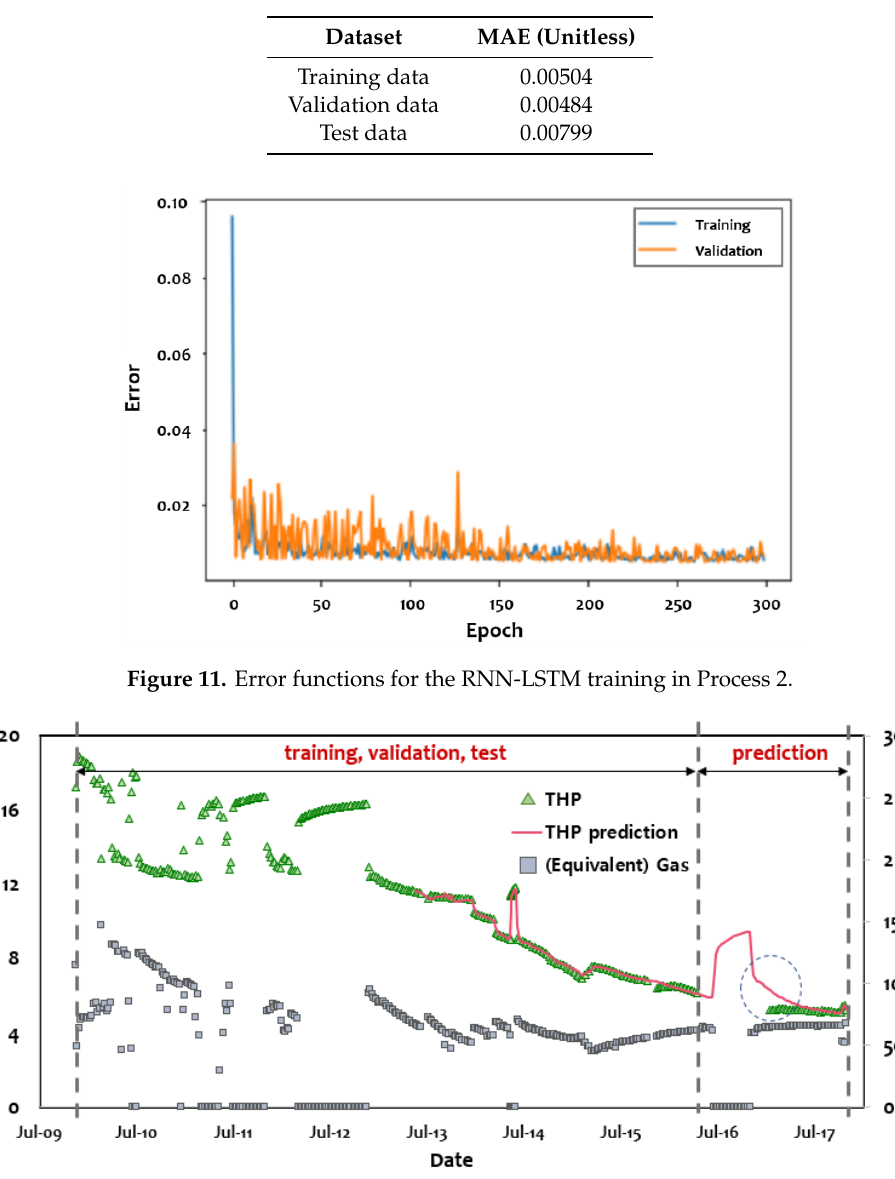
Table 3. Error functions for Process 2.